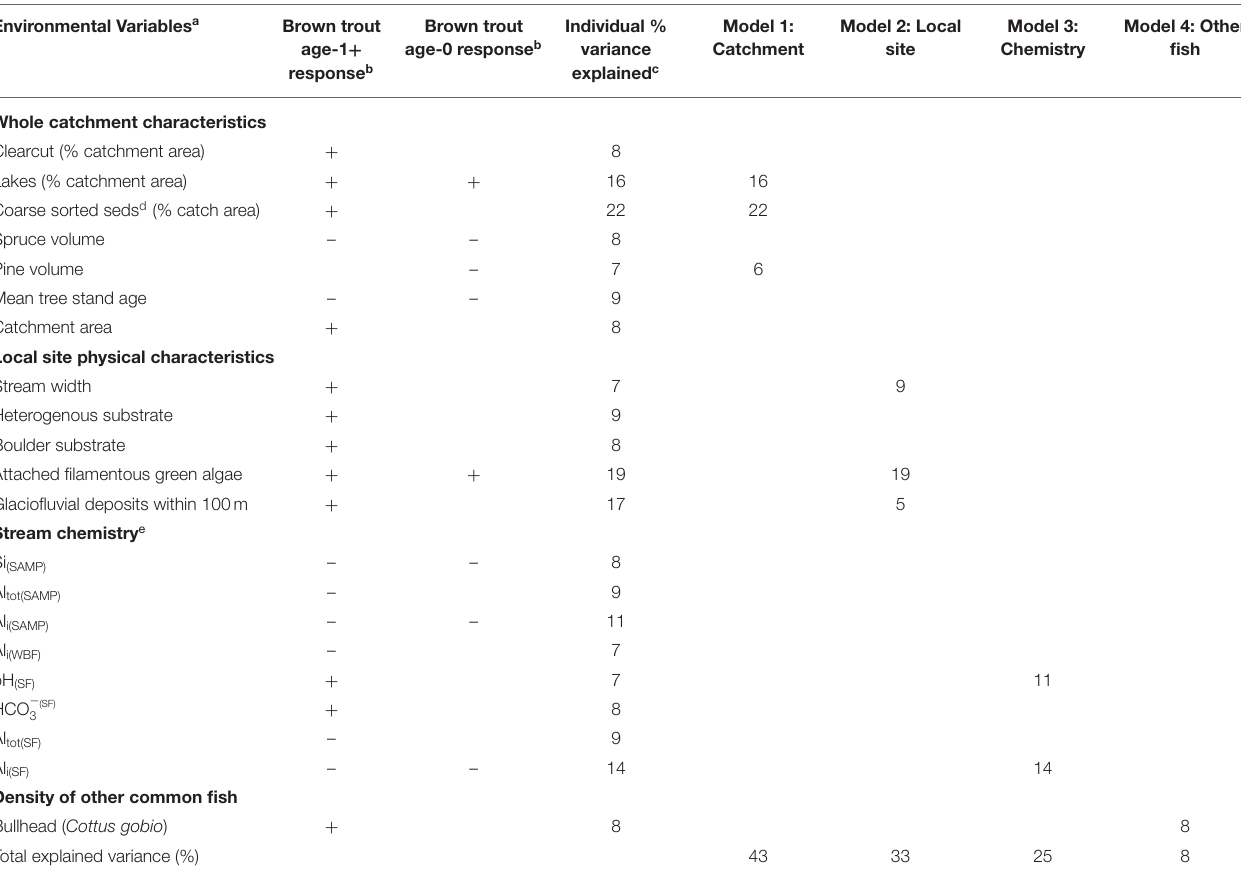
TABLE 5 | Summary of RDA analyses relating environmental variables to age-0 and age-1 + brown trout densities at 47 stream sites. Environmental Variables